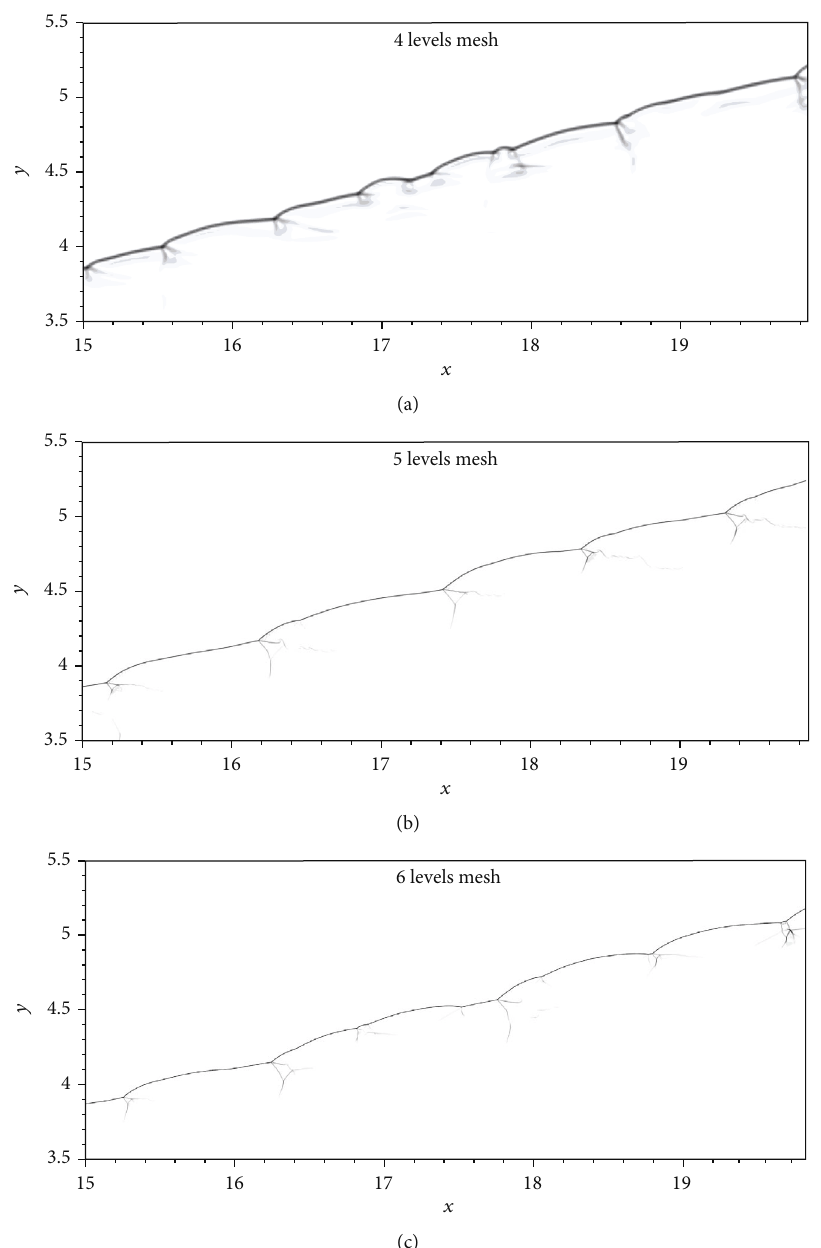
Figure 4: Density gradient contour with 4, 5, and 6 re fi nement level grid. (a) Four re fi nement levels. (b) Five re fi nement levels. (c) Six re fi nement